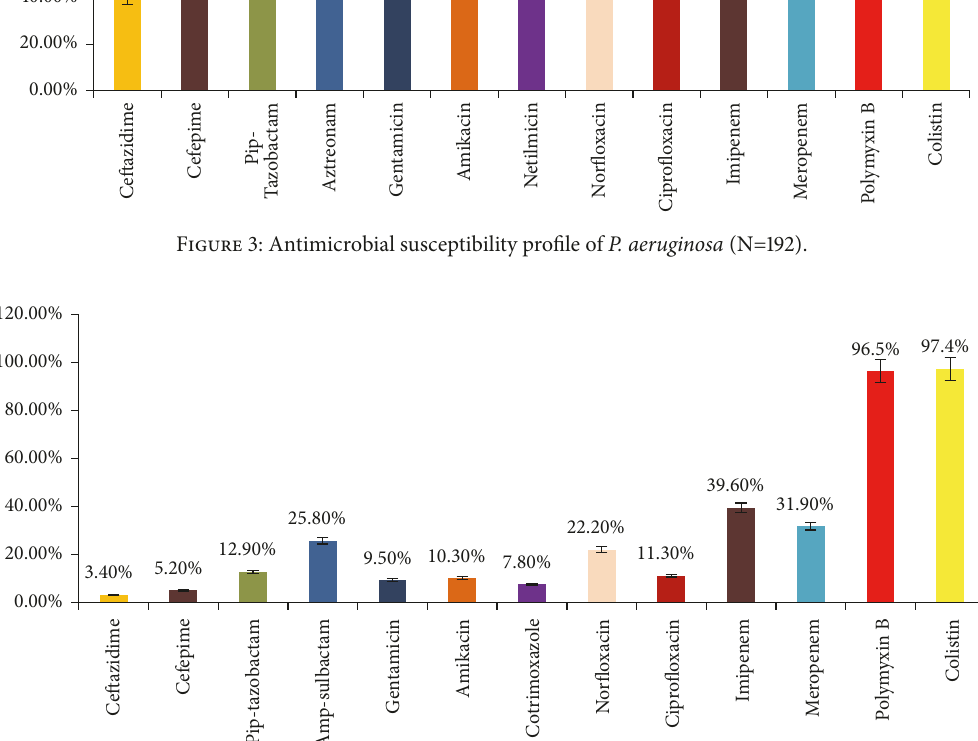
Figure 4: Antimicrobial susceptibility profile of A. baumannii